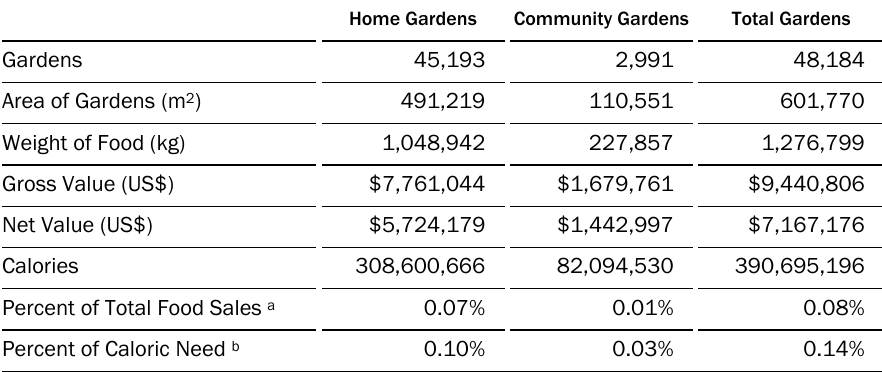
Table 4. Estimated Community Food Production Value for Madison Urban Area Overall Based on Models of Garden Presence and Extrapolated Production Rates Results indicate a substantial absolute contribution, but a relatively low contribution relative to